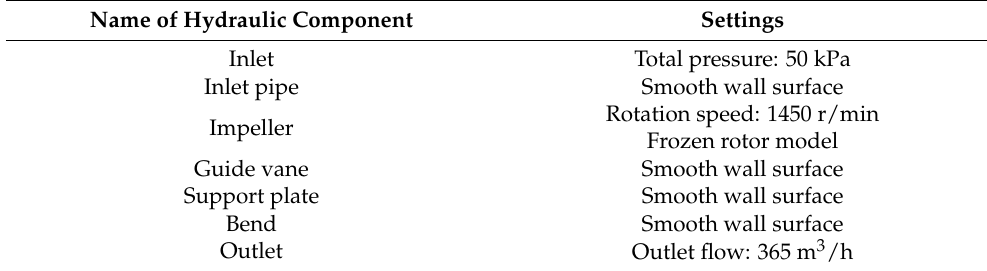
Table 3. Preprocessing condition